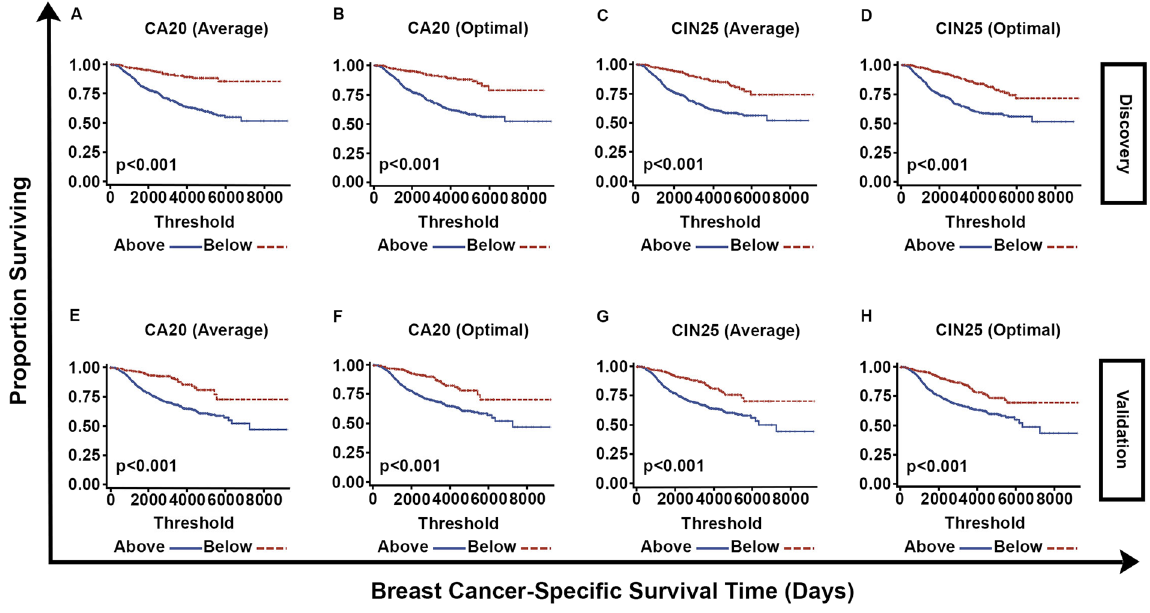
Figure 1. Plots of Kaplan-Meier product limit estimates of breast cancer-specific survival of patients in METABRIC discovery and validation sets stratified by ( A , E ) CA20 (average value), ( B , F ) CA20 (optimal threshold), ( C , G ) CIN25 (average value), and ( D , H ) CIN25 (optimal threshold), respectively. Average values and optimal thresholds were determined using the discovery